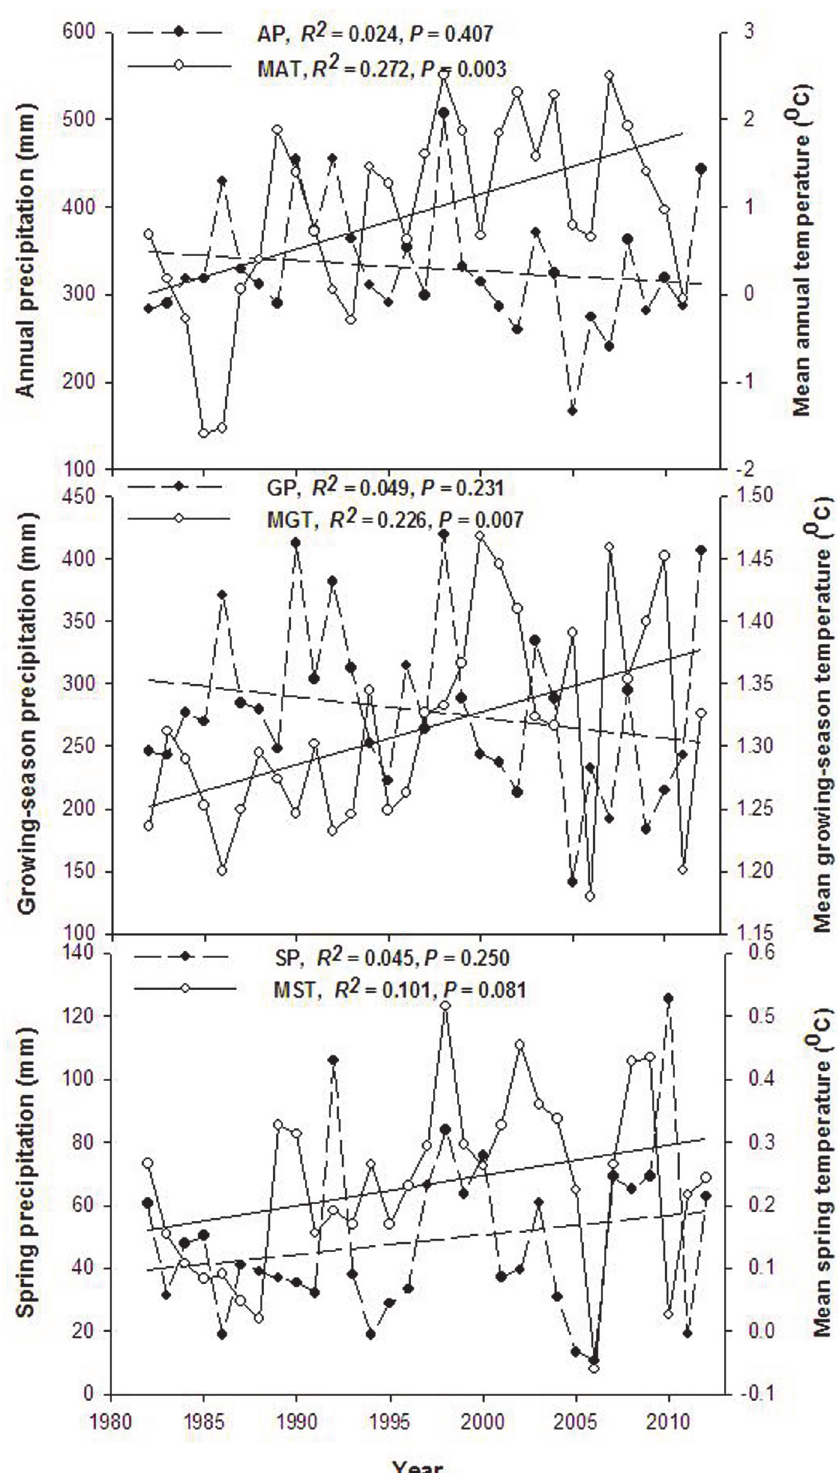
Fig 1. Interannual variation of precipitation and temperature at the study site from 1982 to 2012. AP, Annual precipitation; MAT, Mean annual temperature; GP, Growing-season precipitation; MGT, Mean growing-season temperature; SP, Spring precipitation; MST, Mean spring temperature.